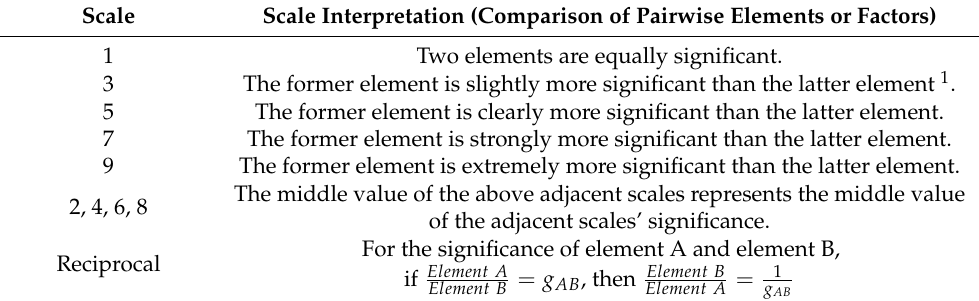
Table 4. Nine-level scaling method and scaling